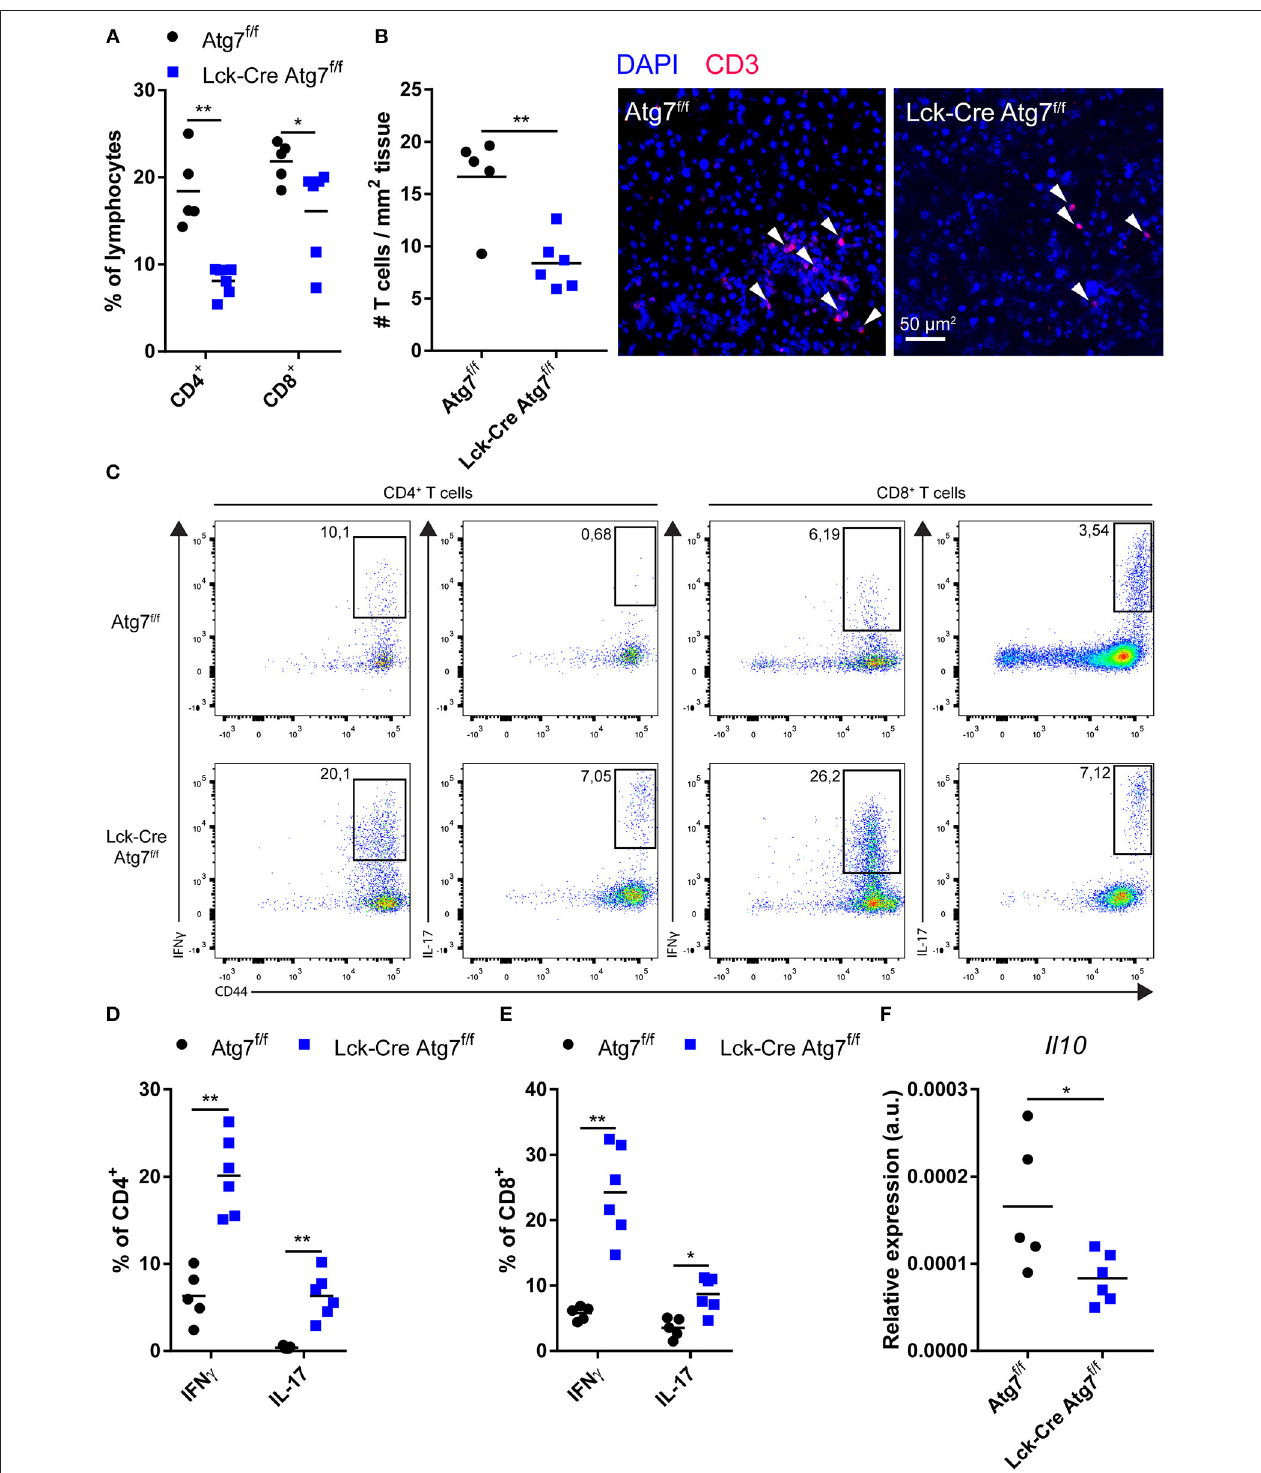
FIGURE 3 | Atg7 deficiency in T cells diminishes T cells in liver but increases relative inflammatory cytokine production. (A) Percentage of CD4 + and CD8 + T cells in live hepatic lymphocyte fraction. (B) Quantification and representative confocal images of T cells in liver (C) Gating strategy to identify IFN γ and IL-17 producing T cells in liver. (D) Percentage of IFN γ and IL-17 producing hepatic CD4 + T cells. (E) Percentage of iFN γ and IL-17 producing hepatic CD8 + T cells. (F) Il10 expression in liver. * p < 0.05, ** p < 0.01.